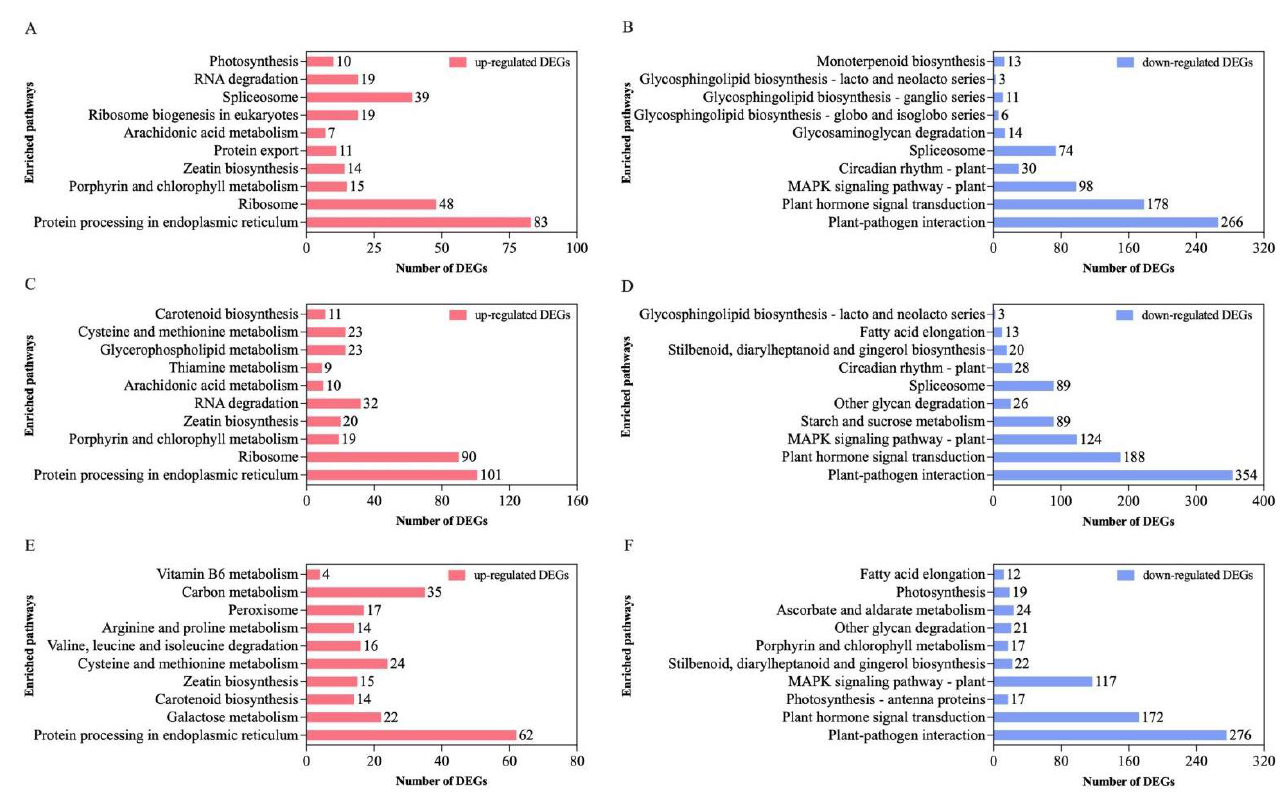
Figure 2. The top 10 enriched pathways of DEGs between HS-treated grapevines and control. ( A ) The top 10 enriched pathways of up-regulated DEGs at 1 hpt. ( B ) The top 10 enriched pathways of down-regulated DEGs at 1 hpt. ( C ) The top 10 enriched pathways of up-regulated DEGs at 4 hpt. ( D ) The top 10 enriched pathways of down-regulated DEGs at 4 hpt. ( E ) The top 10 enriched pathways of up-regulated DEGs at R24 hpt. ( F ) The top 10 enriched pathways of down-regulated DEGs at R24 hpt.